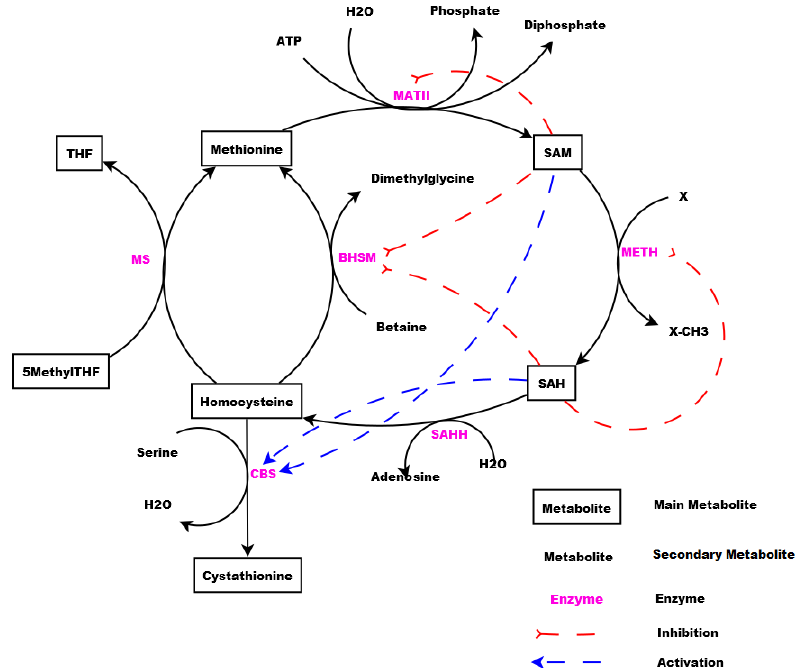
Figure 1. Schematic illustration of the Methionine metabolite cycle. 5MethylTHF: 5-Methyl